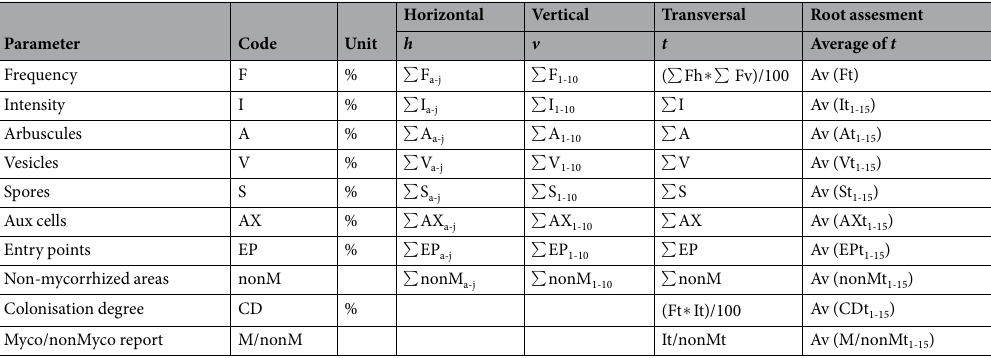
Table 3. Assessment of AM parameters in root